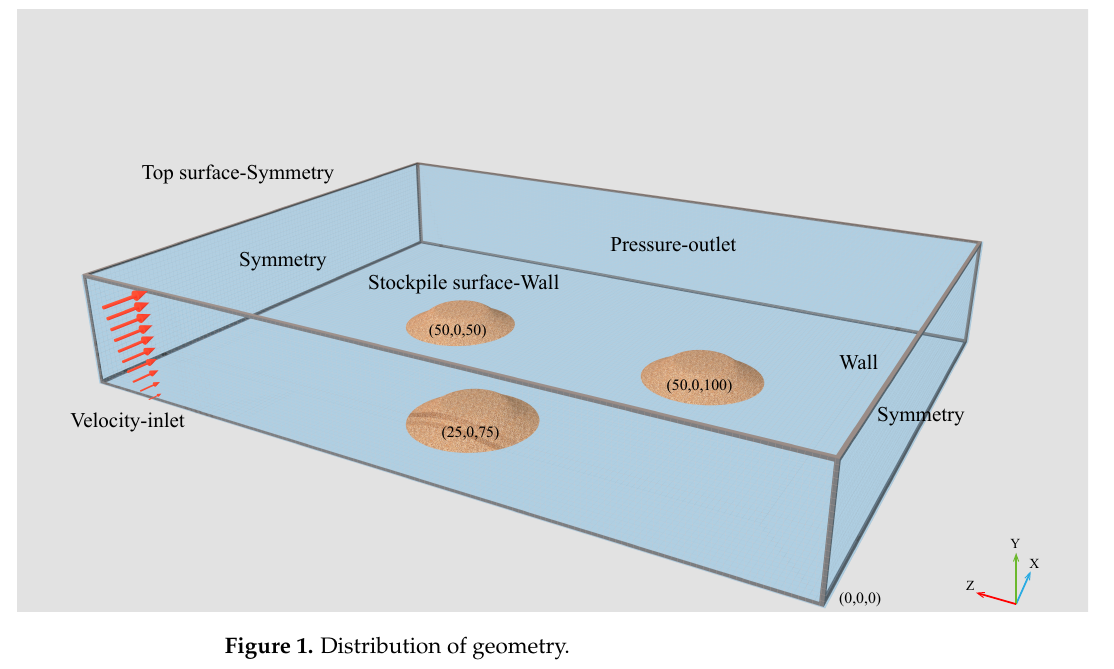
Figure 1. Distribution of geometry.